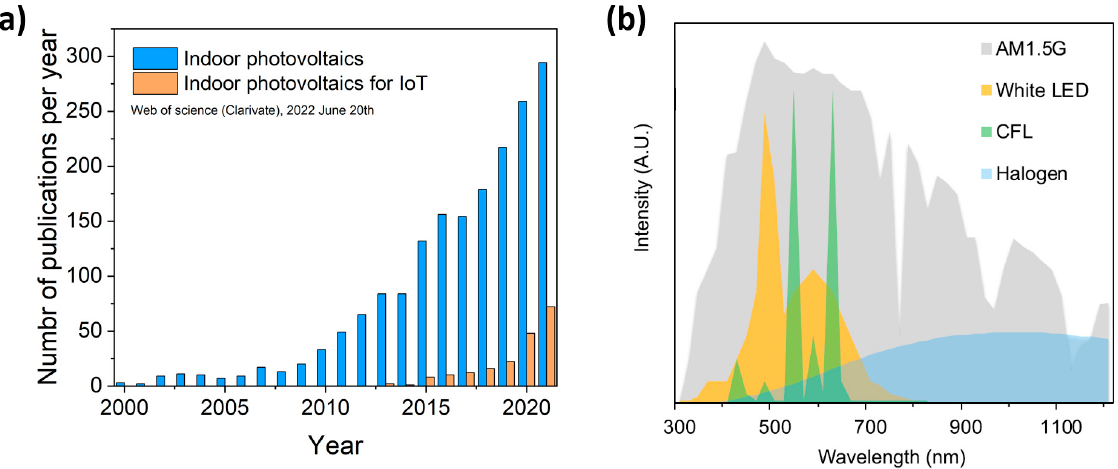
Figure 1. ( a ) Recent bibliography on indoor photovoltaics and on indoor photovoltaics claiming applications for IoT. Data extracted from Web of Science (Clarivate) in July 2022; ( b ) Normalized irradiance of light sources including standard solar spectrum (AM1.5G), white LED, compact fluorescent lamps (CFL), and halogen source. Reprinted from reference [31], with permission from Elsevier.